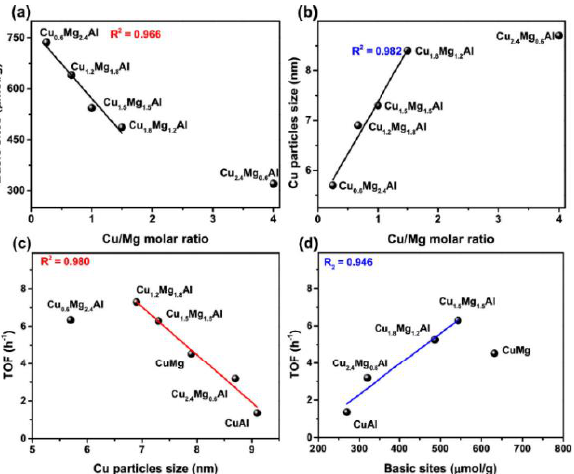
Figure 5. Influence of the molar ratio of Cu/Mg on the ( a ) distribution of basic sites and ( b ) Cu particle size. ( c ) Correlation between the Cu particle size and TOF value and (d) basic sites and TOF value [194]. (Copyright 2022, American Chemical Society).